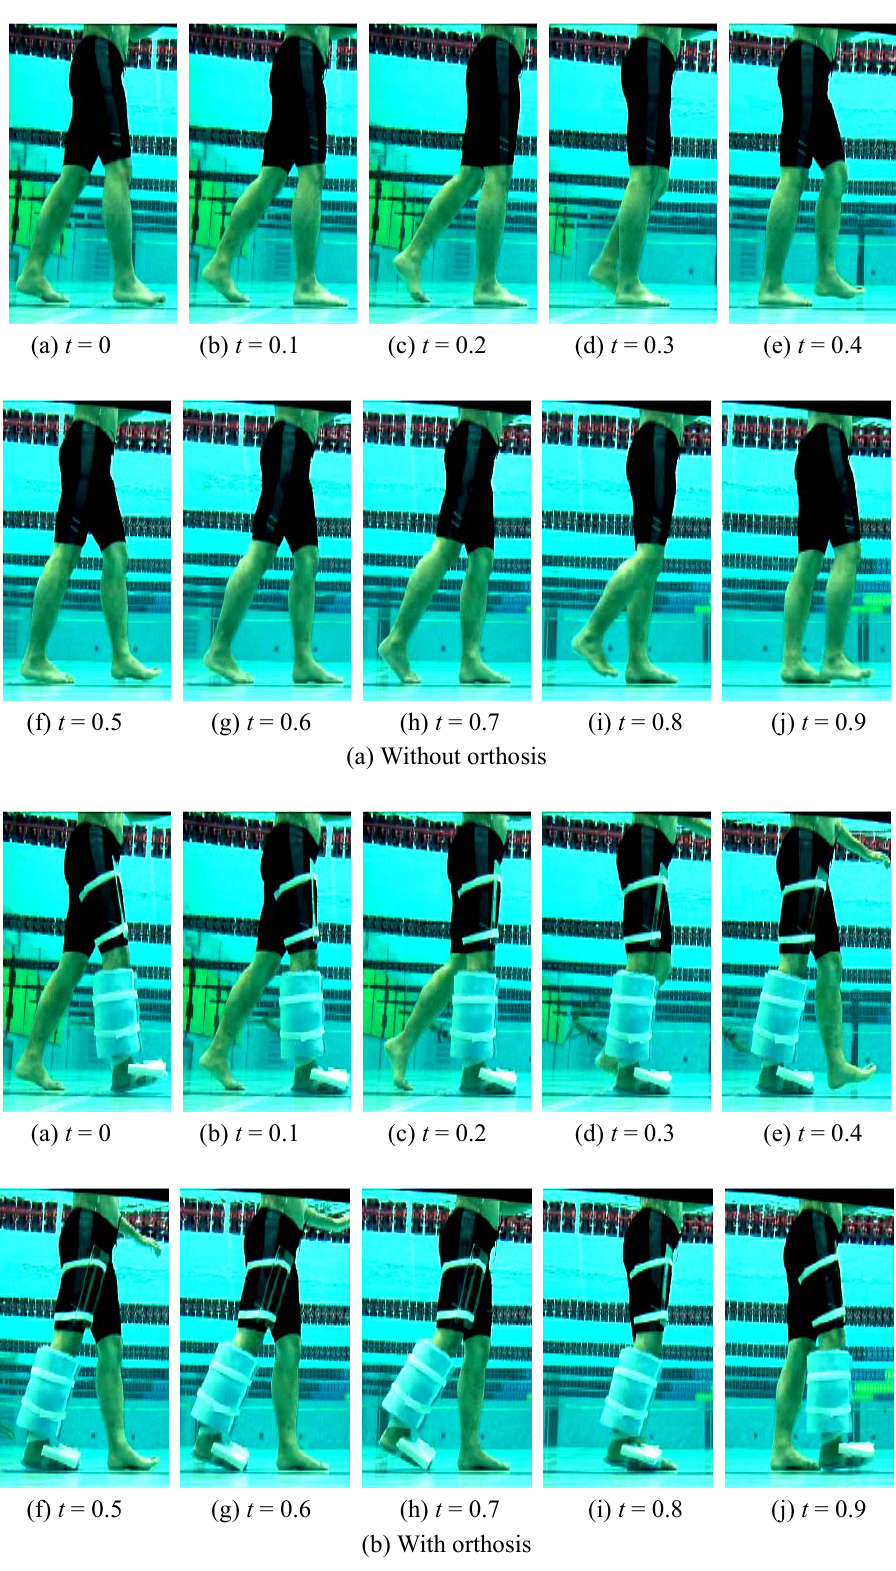
Fig. 12 Comparison of walking forms between with and without